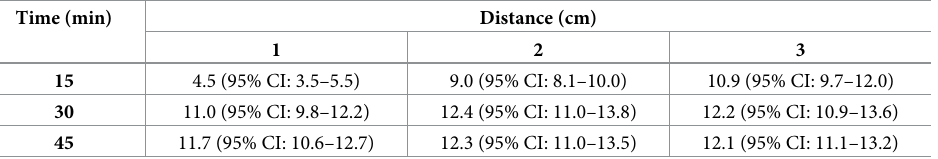
Table 2. Mean estimates with corresponding 95% confidence intervals for VAS pain score due to pin-pricks with a 27G needle at three time points at 15, 30 and 45 minutes after the lidocaine injection with MicronJet600, and distances at 1, 2 and 3 centimeters from the injection